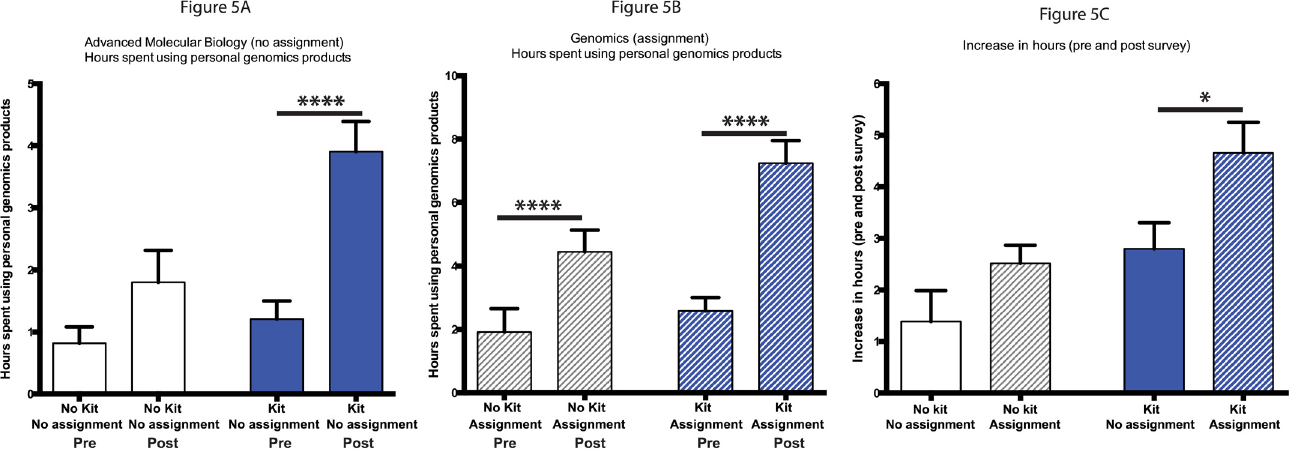
Fig 5. Effect of assignments and kits on time spent using personal genomics products. A) Reported hours spent using personal genomics products for students in Advanced Molecular Biology. Students in this class did not have a required homework assignment. The left two columns are the pre- and post- survey results from students who did not receive kits (white); whereas the right two columns are the survey results from students who did (blue). Statistical analysis performed using a paired t-test and all values are mean ± SEM with n = 40 for no kit/no assignment (white), and n = 42 for kit/no assignment (blue) ( **** = p < .0001). B) Reported hours spent using personal genomics products for students in Genomics. These students had a required homework assignment. The left two columns are the pre- and post-survey results from students who did not receive kits (hatched white); whereas the right two columns are the survey results from students who did (hatched blue). Statistical analysis performed using a paired t-test and all values are mean ± SEM with n = 31 for no kit/assignment (hatched white), and n = 42 for kit/assignment (hatched blue) ( **** = p < .0001). C) The change in hours (increase) between the pre and post tests for each course and group were calculated. In the left two columns were students who did not receive kits. Students who did not have a homework assignment (white) were compared to those that did (hatched white). In the right two columns all students received kits. Students that did not have a homework assignment (blue) were compared to those that did (hatched blue). Statistical analysis performed using an unpaired Student t-test and all values are mean ± SEM with n = 40 for no kit/no assignment (white), n = 42 for kit/no assignment (hatched white), n = 31 for no kit/assignment (blue), and n = 42 for kit/assignment (hatched blue) ( * = p < .05).